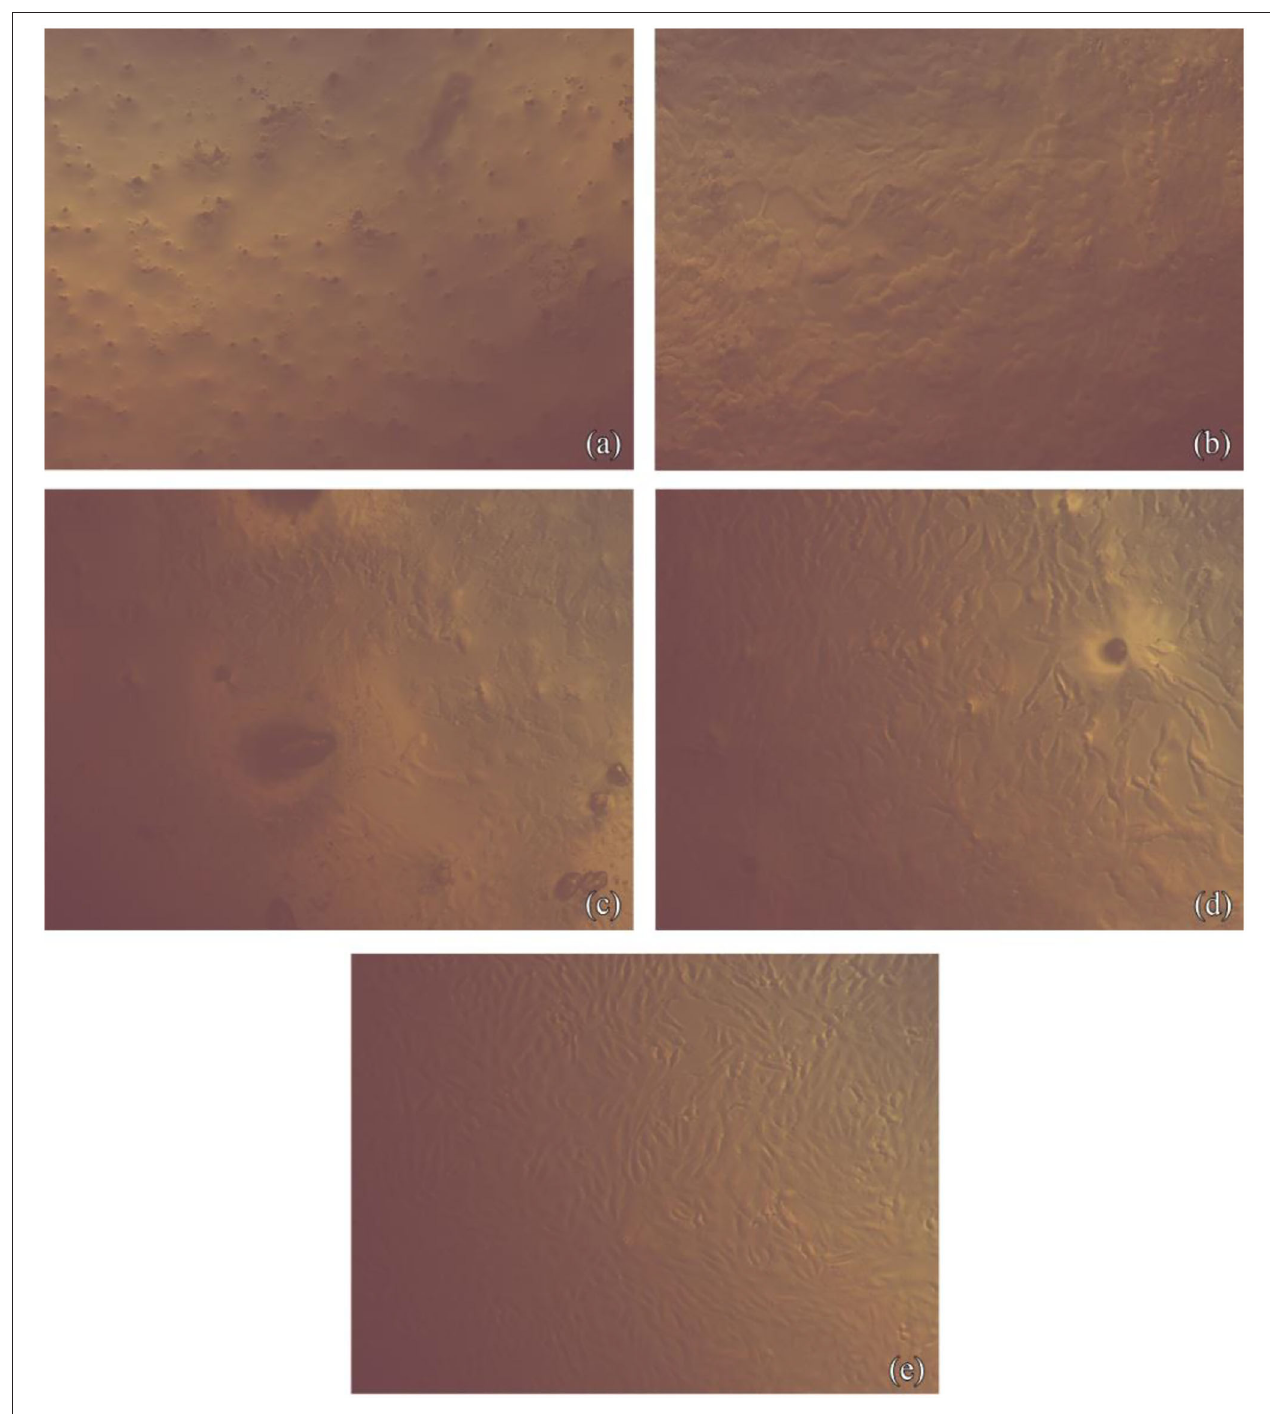
FIGURE 2 | Fibroblasts cells imaged with phase-contrast microscope showing their morphology after contact with NHA-LPS suspension. (a) For 1h at concentration 10 gm/ml, images show lowest cell density with the loss of normal spindle morphology. About 50% of cells became rounded, no granules in the cytoplasm. Cell lysis and empty spaces show between cells. (b) For 1h at concentration 2.5 gm/ml, images show little spindle cells shrunk, separating from the substrate and visible intraplasmic granules. (c) For 5min at concentration 10 gm/ml, images show lowest cell density with the loss of normal spindle morphology. Approximately 50% of cells became rounded, no granules in the cytoplasm. Cell lysis and empty spaces show between cells. (d) For 5min at concentration 2.5 gm/ml, images show little spindle cells shrunk, separating from the substrate, and visible intraplasmic granules. (e) Normal fibroblast cells as a control.